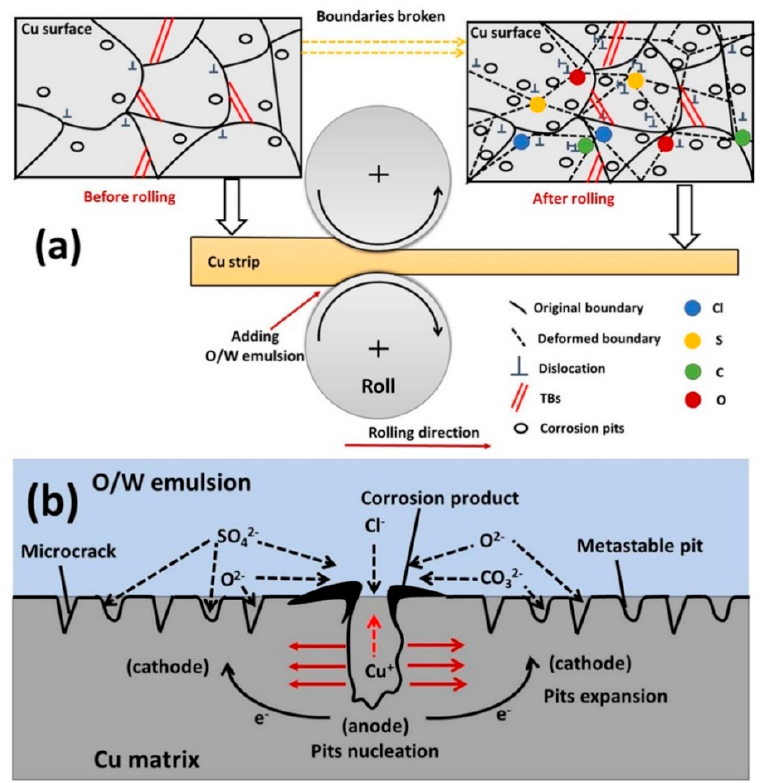
Figure 13. ( a ) Mode of the whole corrosion behavior of a Cu strip rolled with O/W emulsions; ( b ) mechanism of pitting corrosion expansion. ( b ) mechanism of pitting corrosion